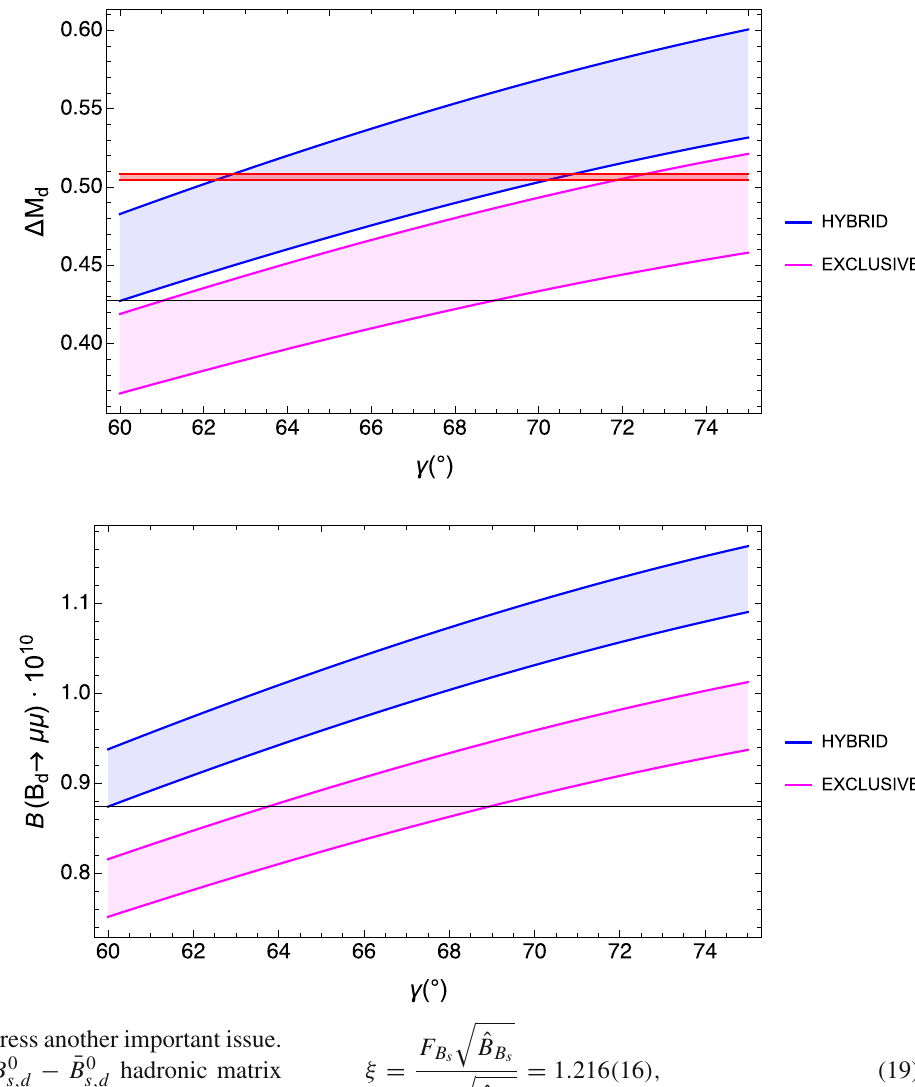
Fig. 5 (cid:2) M d and the branching ratio B ( B d → μ + μ − ) as functions of γ , in the EXCLUSIVE and HYBRID scenarios. The bands represent the uncertainties related to | V cb | , | V | , | V | and to the non-CKM ub us parameters. The red band in the upper panel represents the experimental value for (cid:2) M d , with its 1 σ